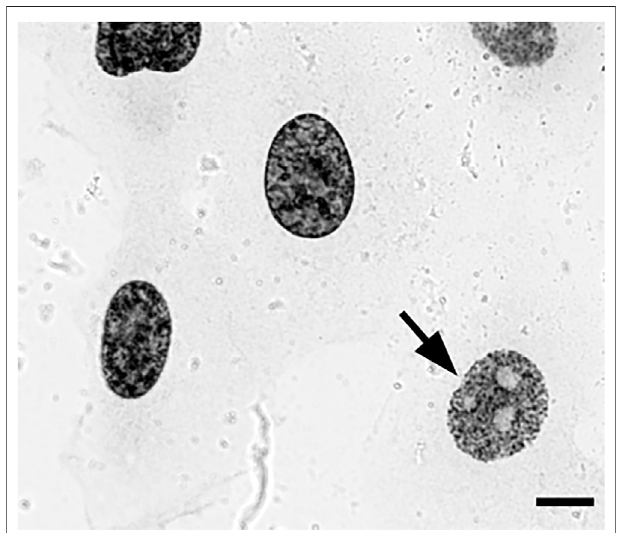
FIGURE 2 | EdU pulse-labeled HT1080 cells after biotin-azide streptavidin-Nanogold detection and embedding demonstrate clear replication patterns en bloc under a transmitted light microscope, enabling selectionofcellswithearly-Spatterns(arrow) forsectioning. Bar, 10 μ m.